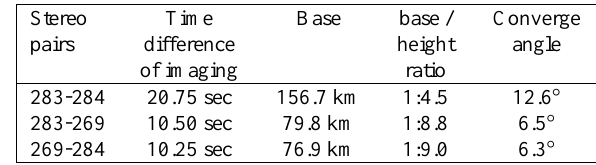
Table 8. Stereo imaging configuration